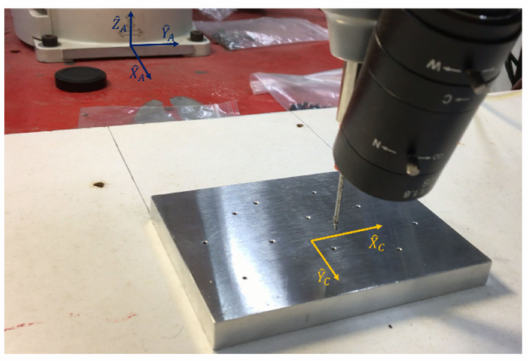
Figure 6. Positions of the coordinate systems { A } and { C 2 }. Coordinate system { C 2 } moves with the manipulator. The coordinate system { D } is defined as having the same ˆ X and ˆY values as those of { C 2 }, but a different origin, as shown in Figure 7. From its position, the manipulator descends vertically to touch the workpiece with the screw. The point at which the screw touches the workpiece is the origin of { D } and thus also has equal ( x , y ) to the coordinates of the manipulator. If the origin of { D } is at the center of the screw hole, the screw is considered to be aligned over the screw